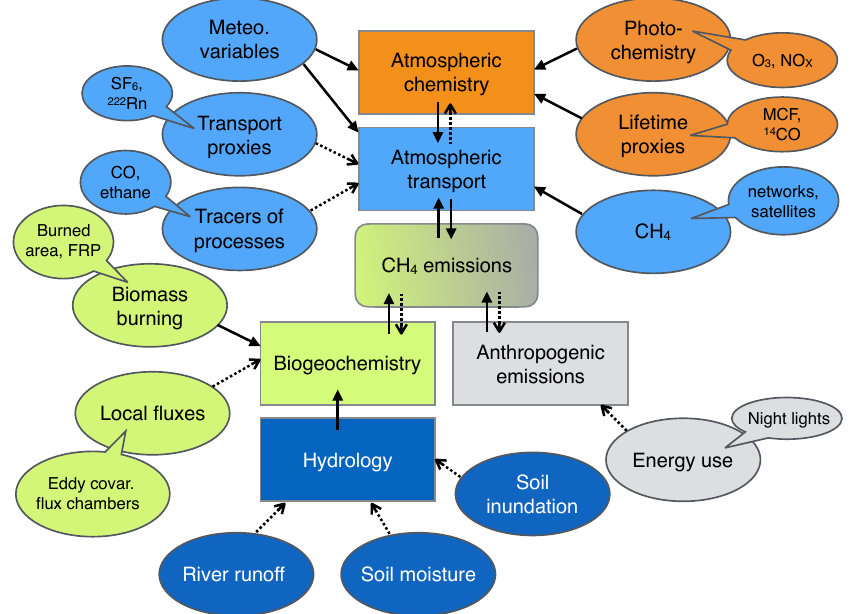
Figure 4. Conceptual diagram of ways to extend the use of measurements in CH 4 flux inversions. Square boxes represent models, ovals represent measurements, and the rounded box represents the target variable of the CH 4 inversion. Call outs provide examples of the kind of measurements that are meant by the ovals (without attempting to be complete). Black arrows: coupled and assimilated into inversions already; dashed arrows: not (yet) coupled or